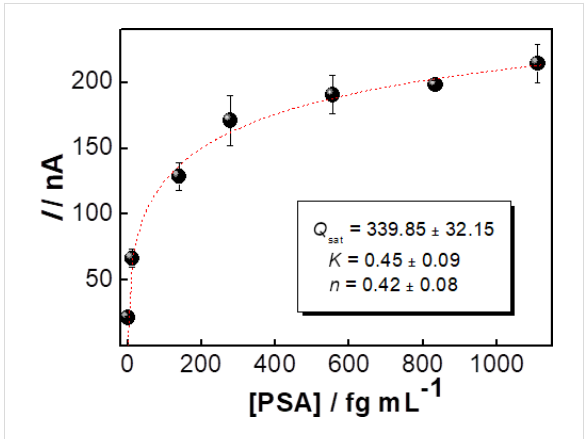
Figure 2: Peak current as a function of the PSA concentration fitted with a Langmuir–Freundlich equation (dashed